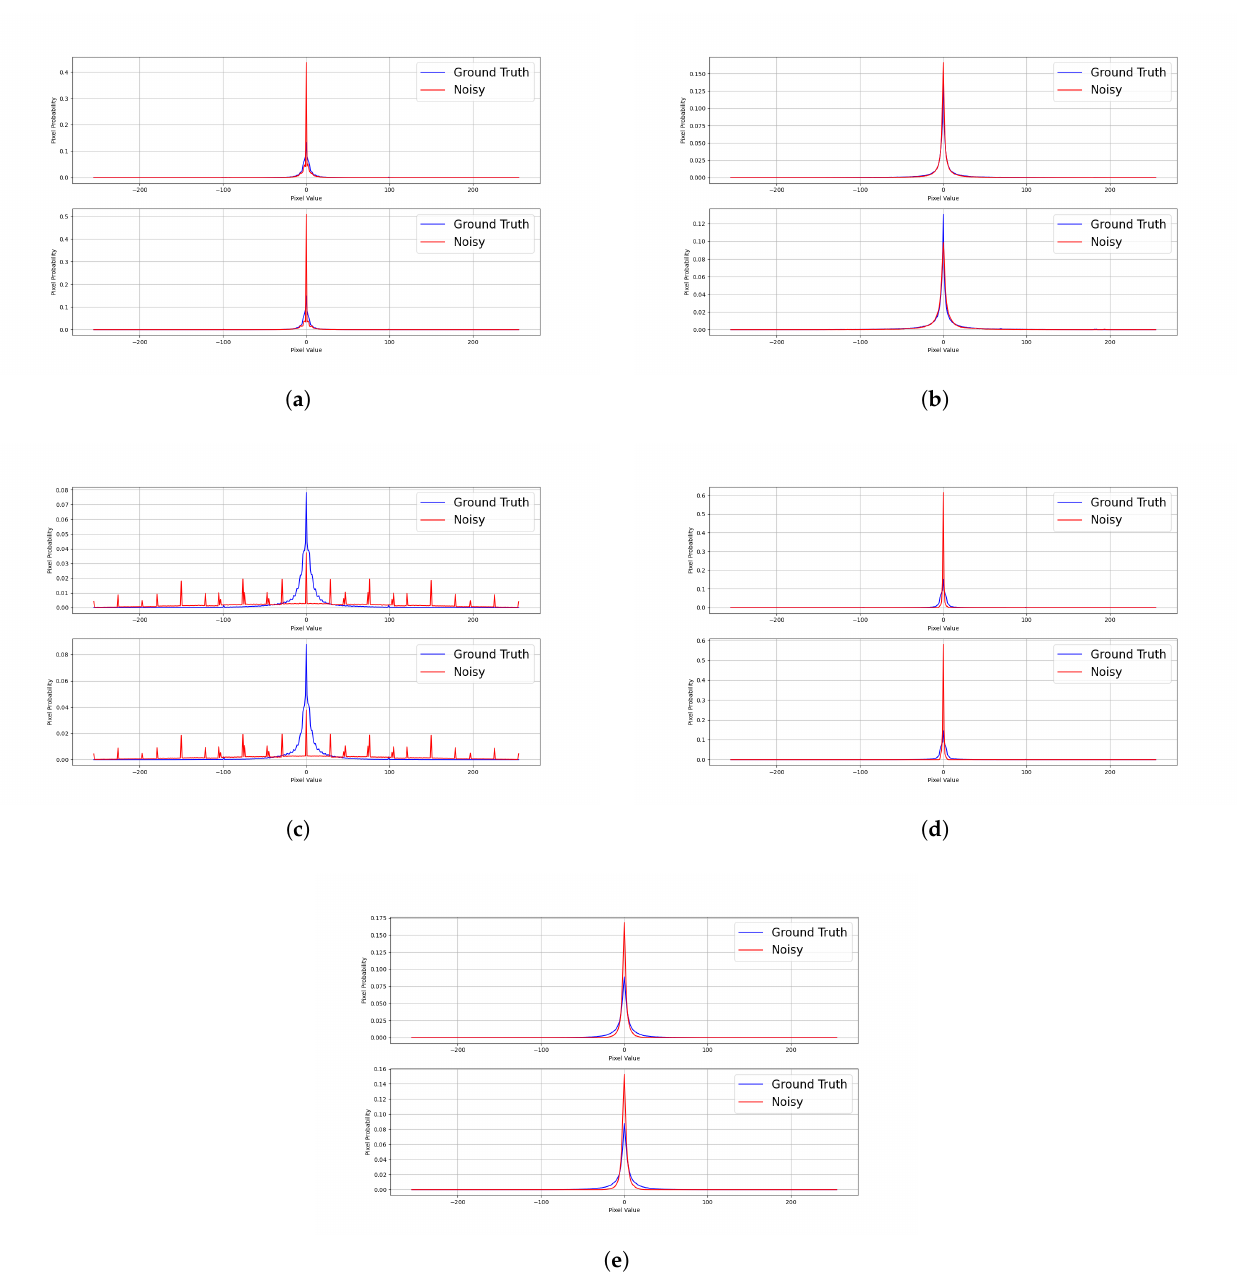
Figure 5. Image gradient distribution for each type of distortion in the LIVE dataset. The up- per graph is the image gradient in x, while the lower graph is the image gradient in y. Cases: ( a ) JPEG2000 compression, ( b ) JPEG compression, ( c ) white noise, ( d ) Gaussian blur, and ( e ) fast- fading Rayleigh